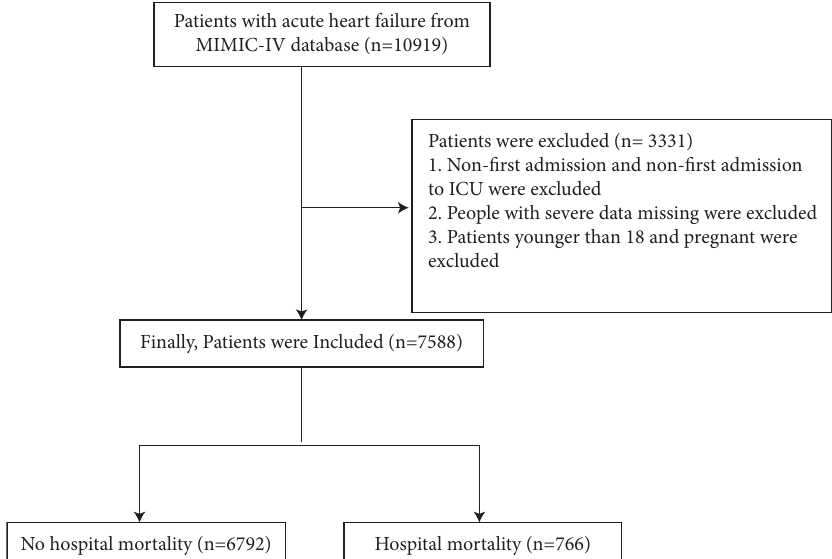
Figure 1: Flow chart of patient selection included in this study. Abbreviations: MIMIC-IV, Te medical information mart for intensive care